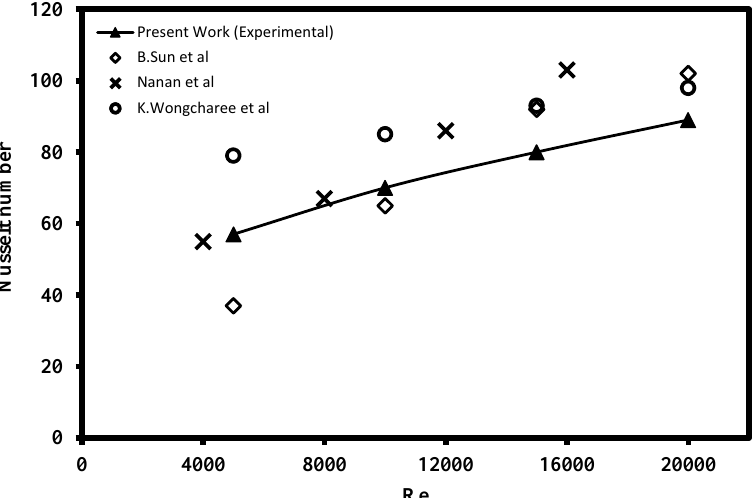
Figure 13. Nusselt number validation test of the experimental swirling impinging jet with water at H/D = 4.